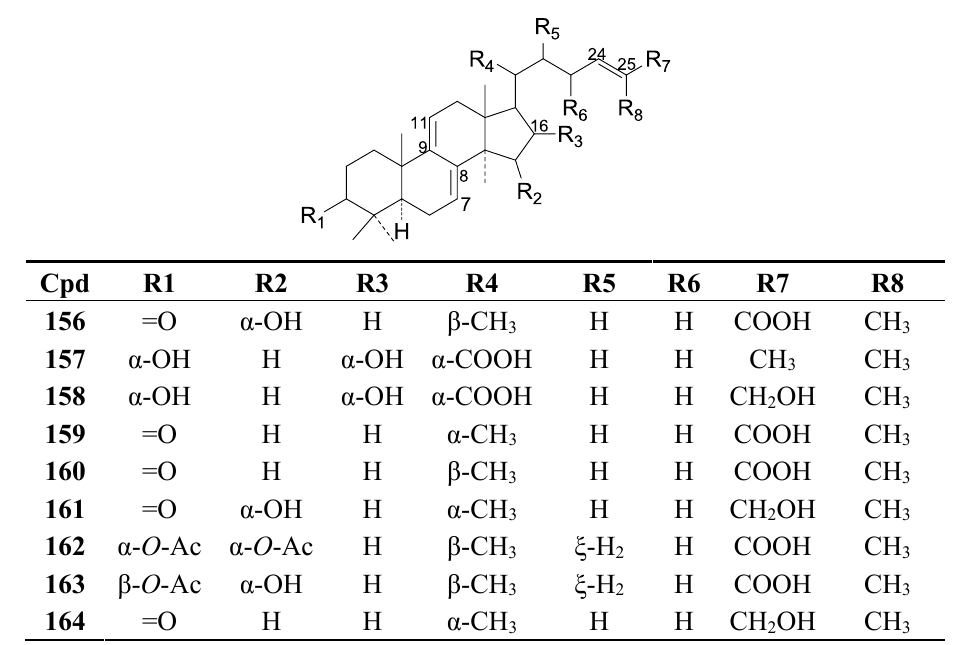
Figure 19. Structures of compounds 156 – 196